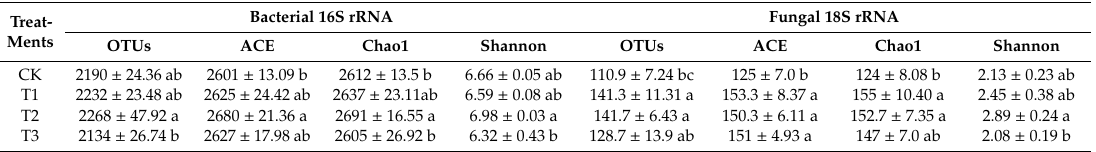
Table 3. Comparison of the estimated OTUs richness and diversity indices of microbes clustering at 97% identity, as obtained from Illumina sequencing under different treatments. Taxonomic alpha diversity was measured as OTU richness (number of OTUs), estimated richness (Chao1 and ACE), and diversity (Shannon index).